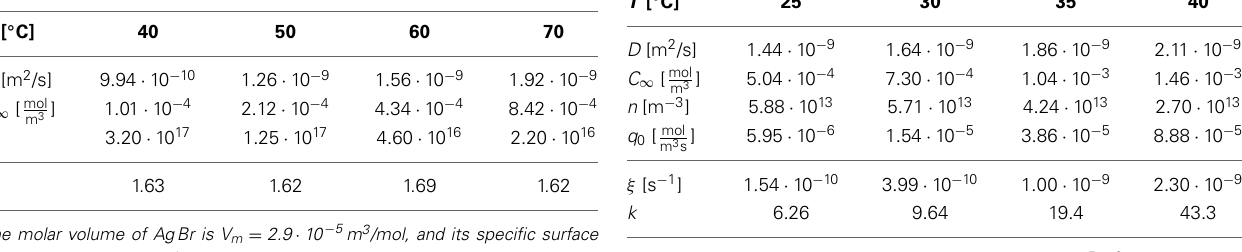
supply rate, Q 0 = 10 − 3